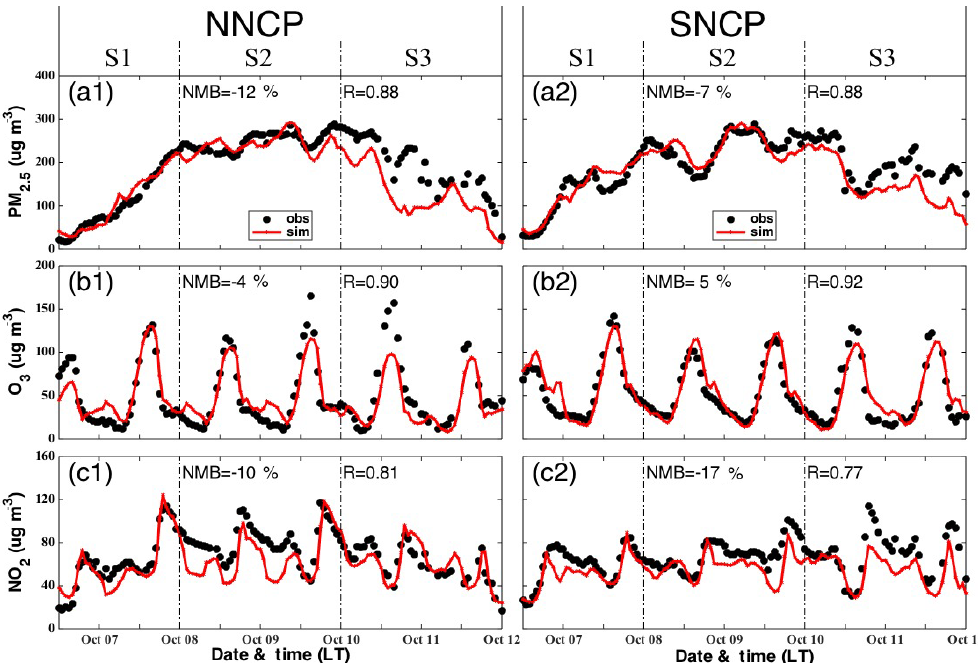
Figure 4. Regional average temporal variations in simulated (in red) and observed (in blue) results of species concentrations of (a) PM 2 . 5